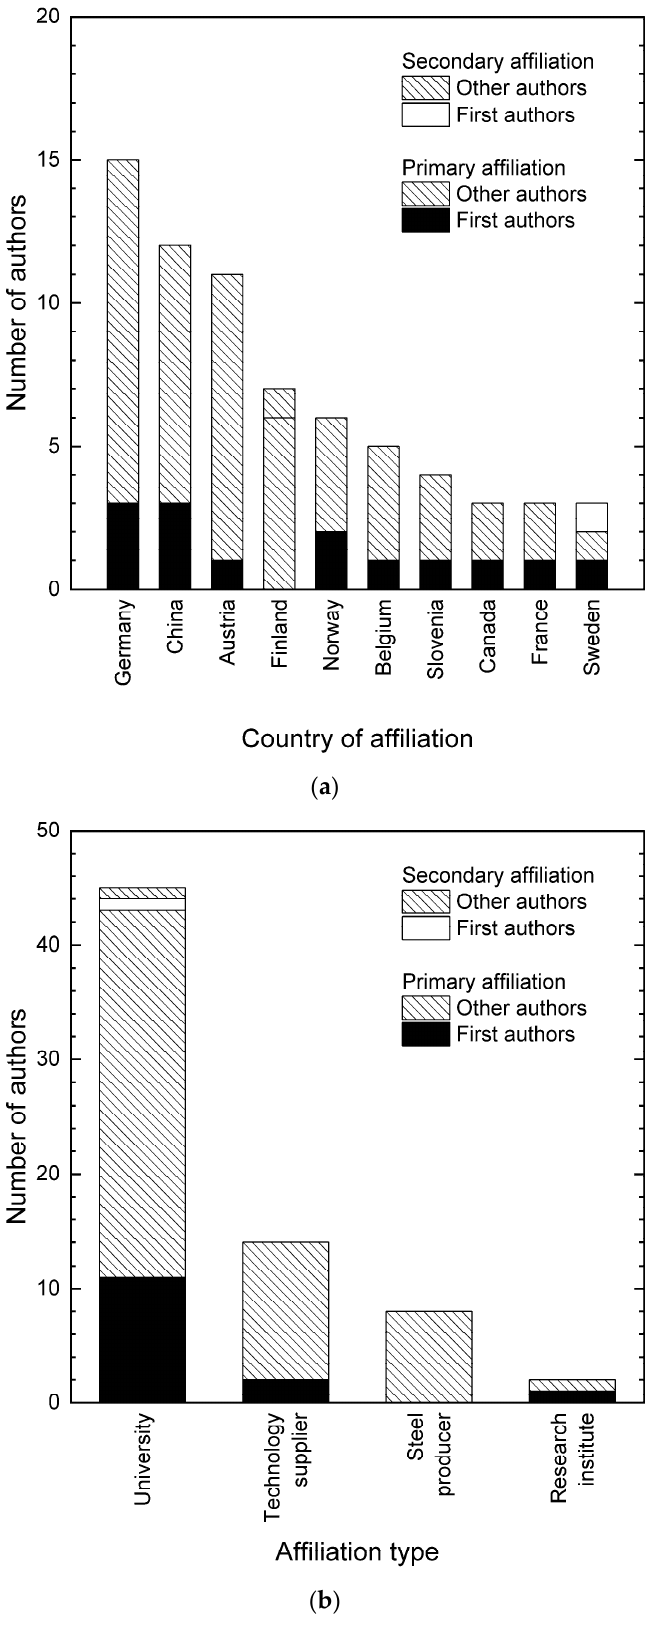
Figure 1. Authors of the contributions of the Special Issue: ( a ) by country of affiliation; ( b ) by affiliation type.